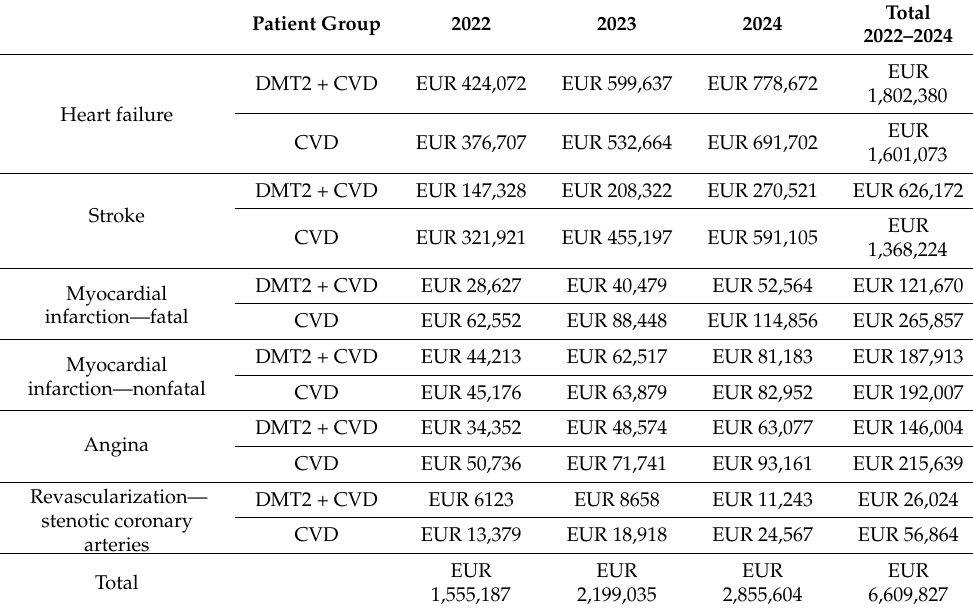
Table 11. Cost savings: reduced incidence of unwanted clinical